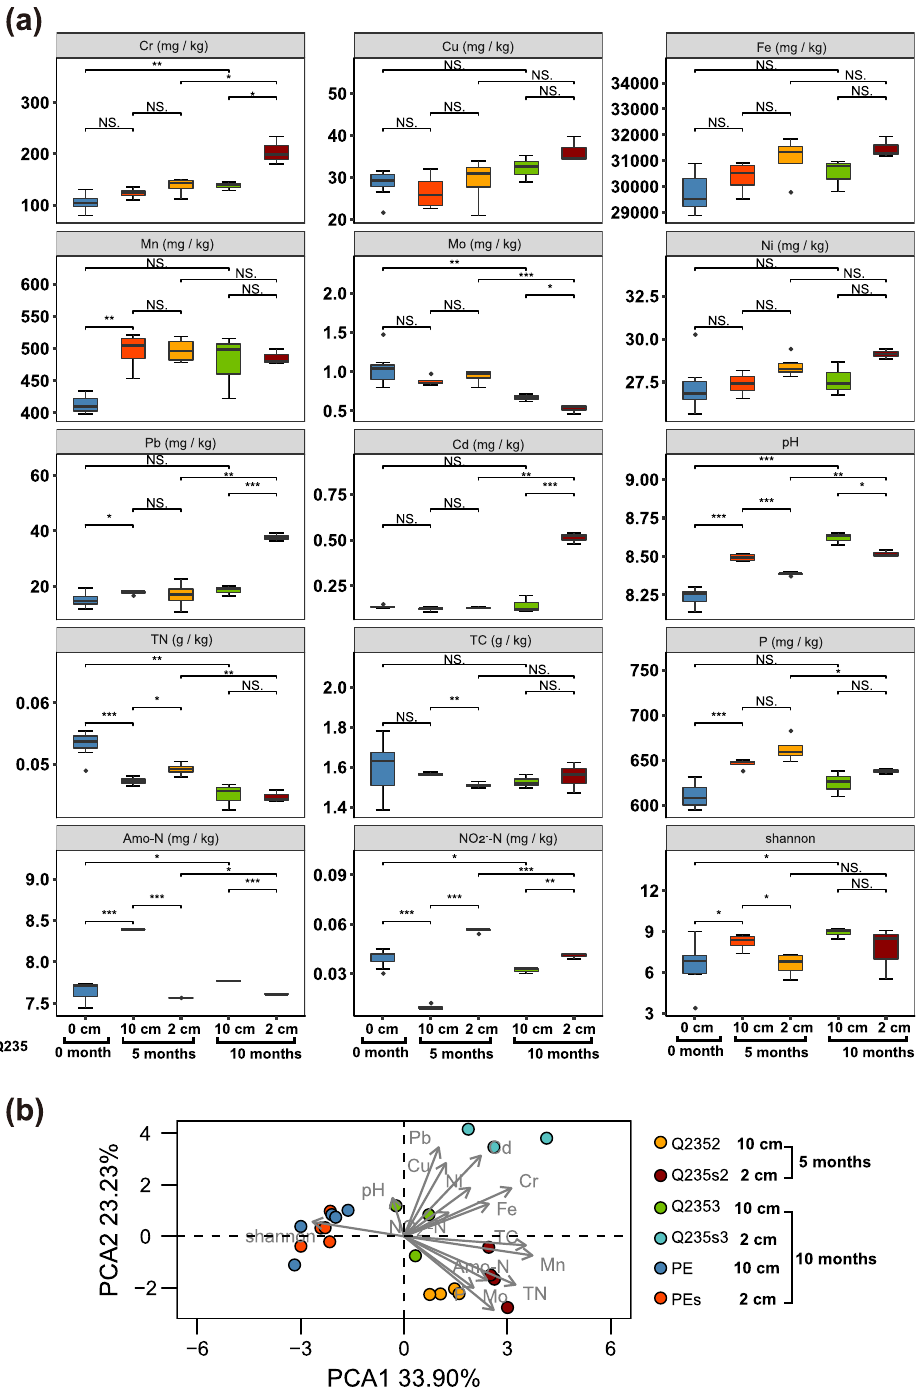
Fig. 2 Physicochemical properties of the soil for Q235 groups. Differences in physicochemical properties of the soil at different time points and different distances (from left to right, n = 7, 4, 4, 3, and 3) for Q235 coupons ( a ) and principal component analysis (PCA) of soil parameters for Q235 and PE ( b ). Note: error bars represented SD; * p -value < 0.05; NS, means p -value > metal surface buried for 5 months were observably different from those at 10 cm from the metal surface with respect to microbial community composition (for Q235, ADONIS, F = 3.73, p = 0.05; for X80Cu, ADONIS, F = 4.65, p = 0.05) (Supplementary Table 5). No signi fi cant difference existed between soil at 2 cm from Q235 and X80Cu surfaces buried for 5 months. The variance analysis results with respect to MDS1-MDS4 further con fi rmed the fi ndings of the NMDS analysis and the signi fi cant differences between samples at